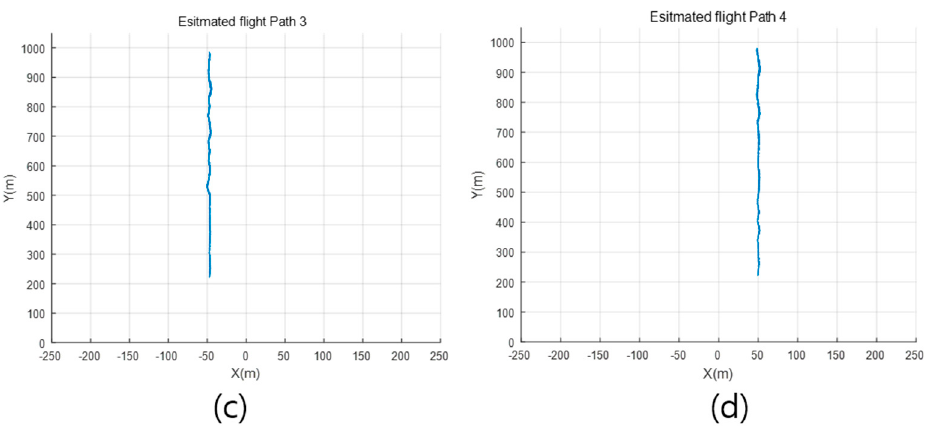
Figure 20. Estimated flight paths, ( a ) estimated path 1; ( b ) estimated path 2; ( c ) estimated path 3; ( d ) estimated path 4.